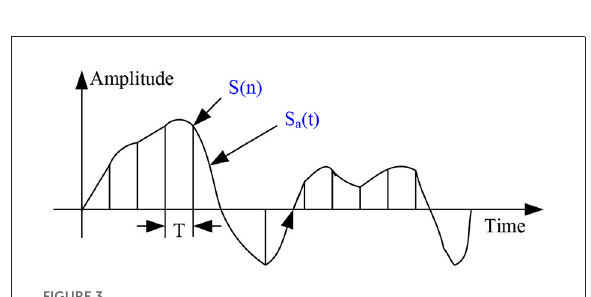
FIGURE3 Discretization diagram of speech